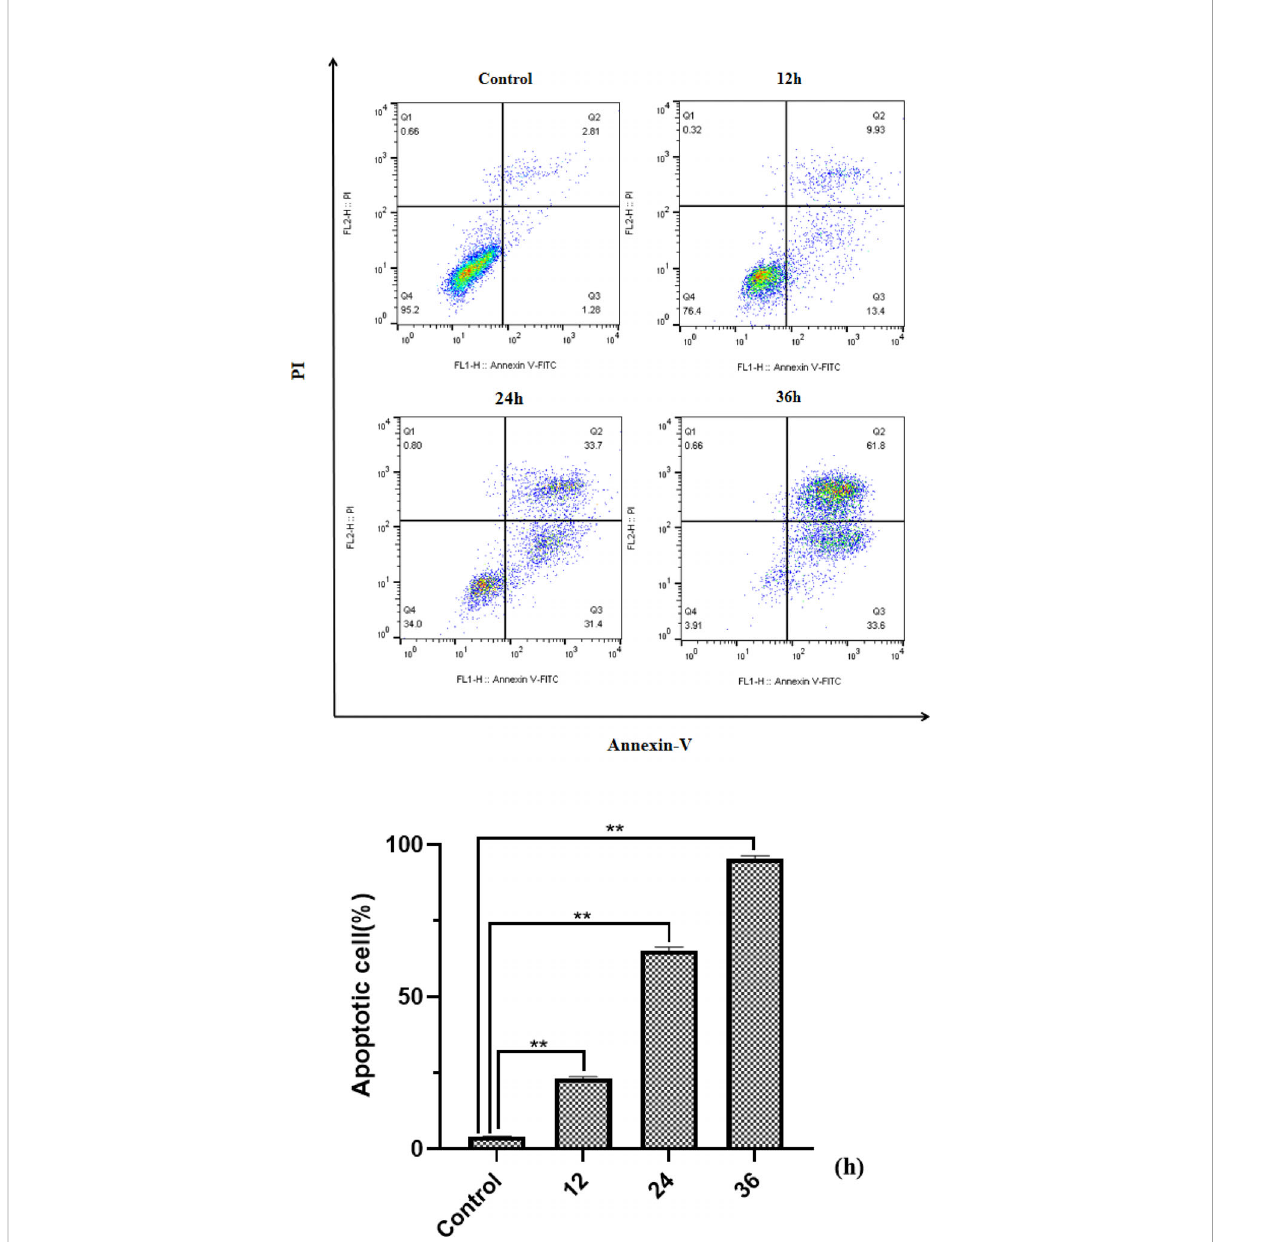
FIGURE 6 Effect of HP-1 on the apoptosis of NCI-H460 cells in time dependence. Data shown are the mean ± SD of three independent experiments (** p <0.01 compared to negative